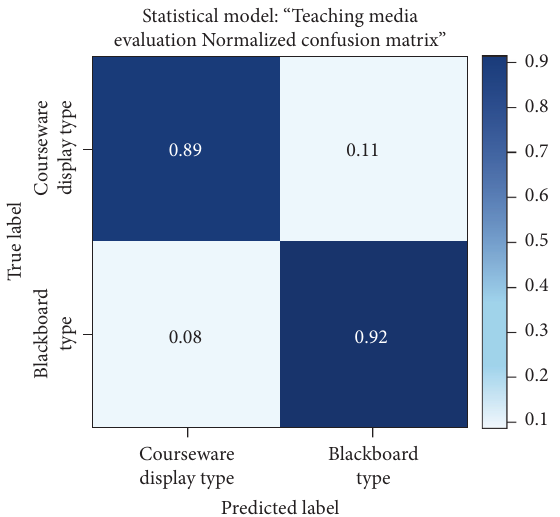
Figure 3: Statistical model: display of evaluation performance of “evaluation of teaching